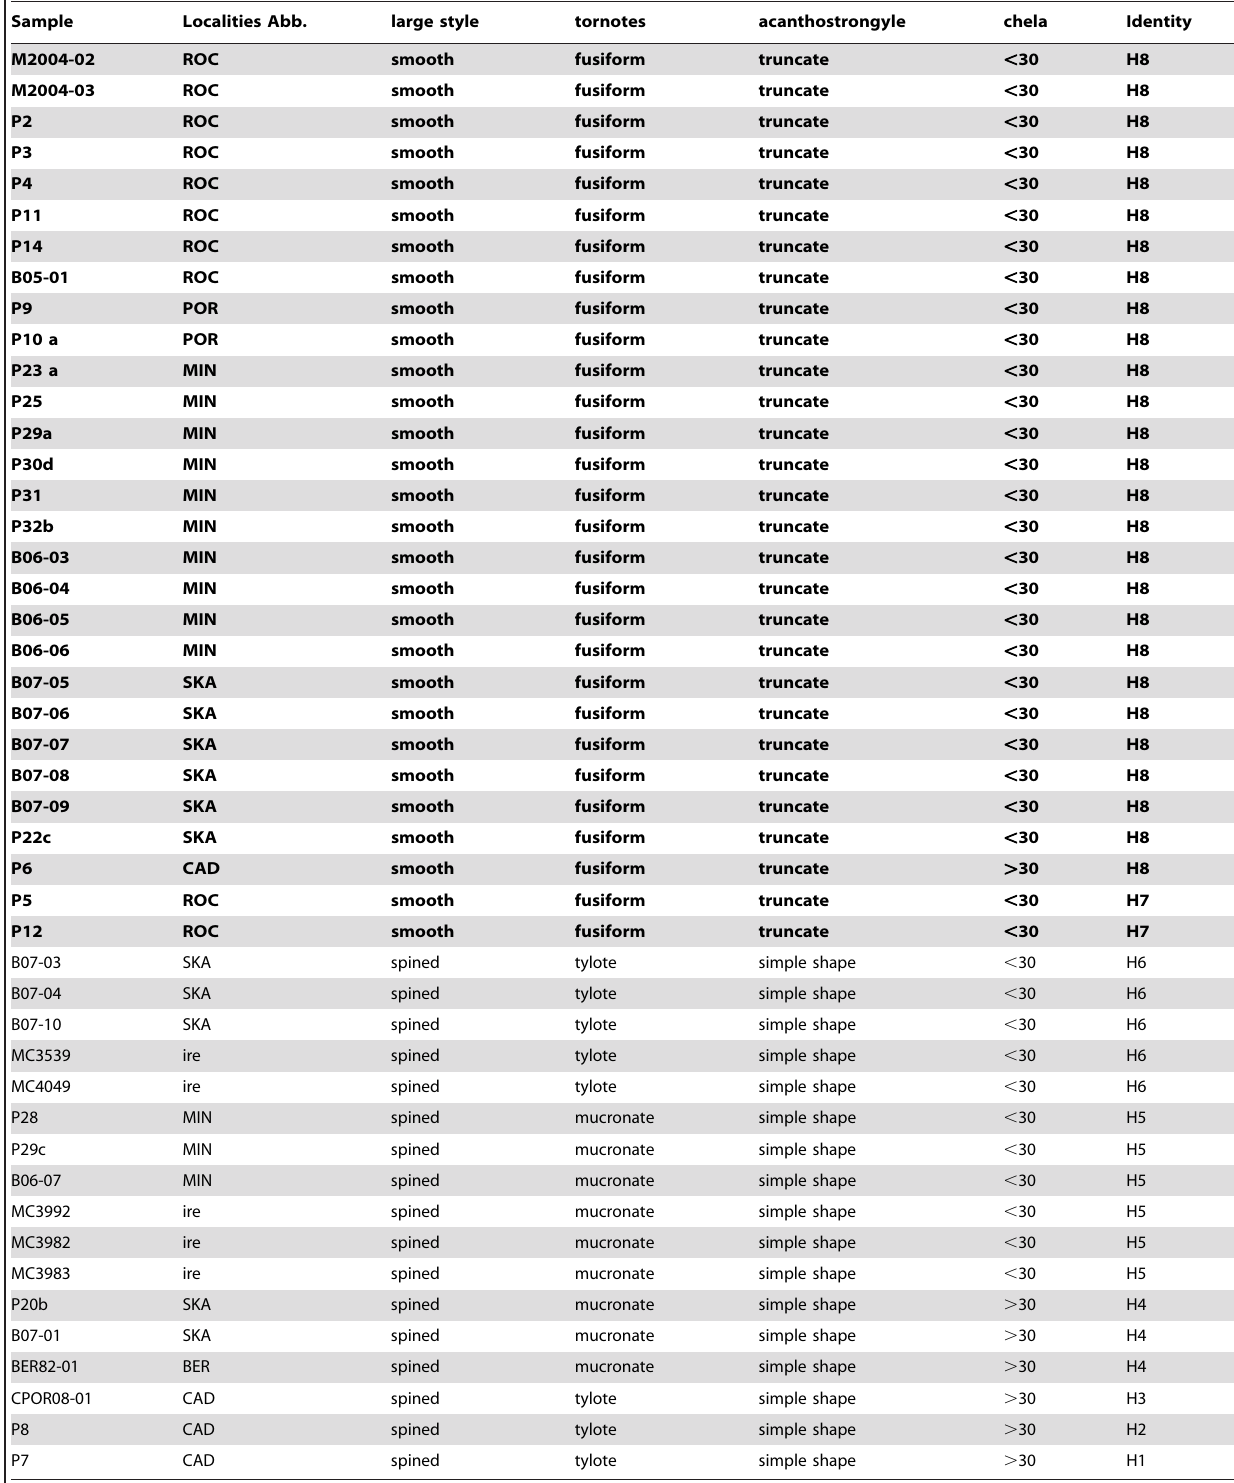
Table 3. Morphological characters of Plocamionida specimens.